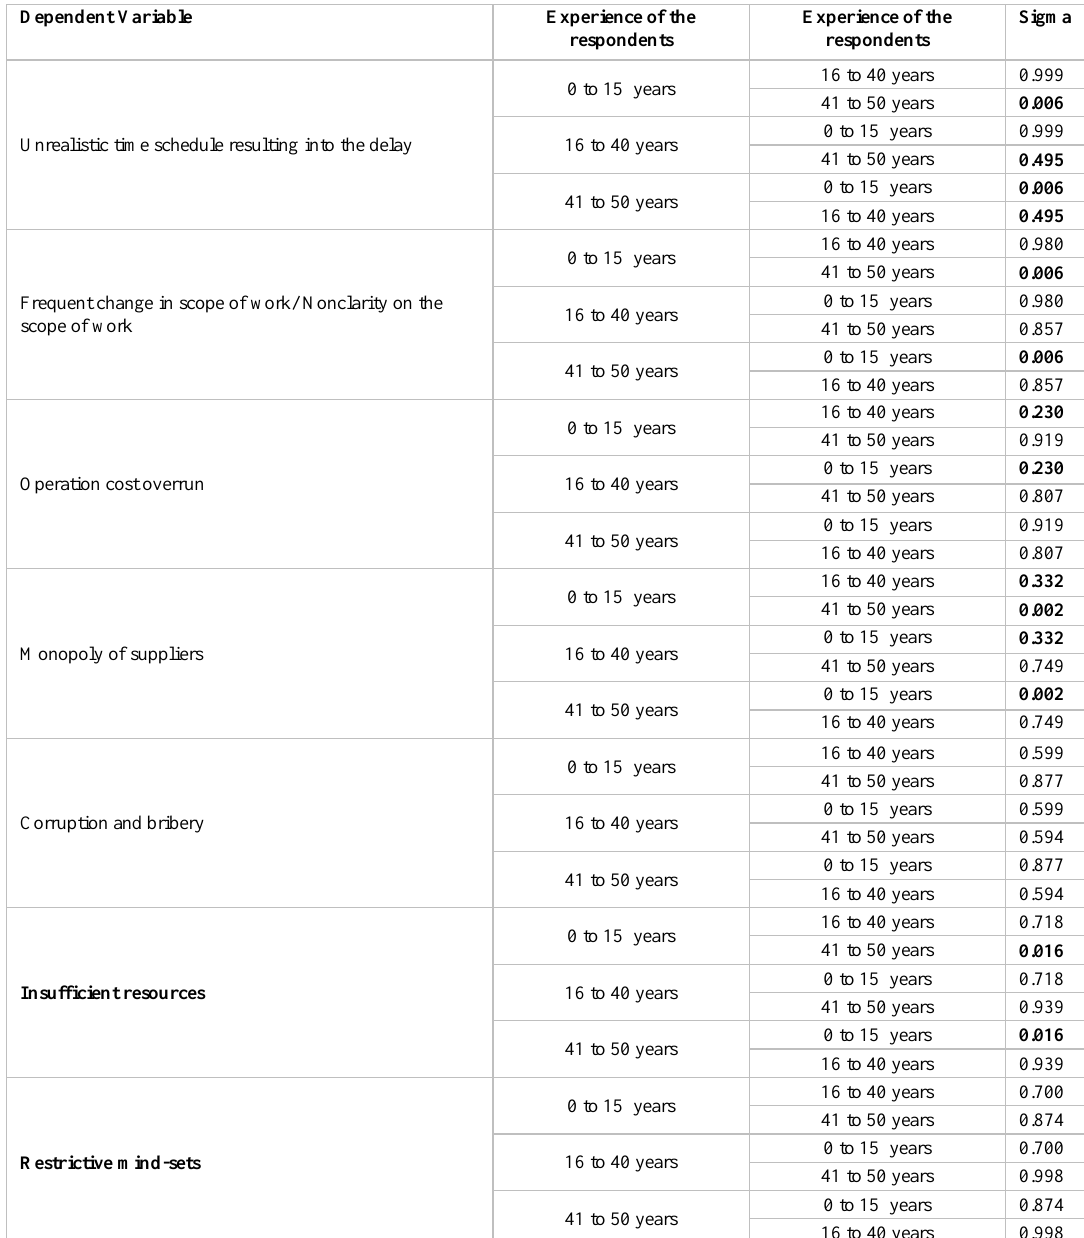
Table 5. Sigma for qualification for